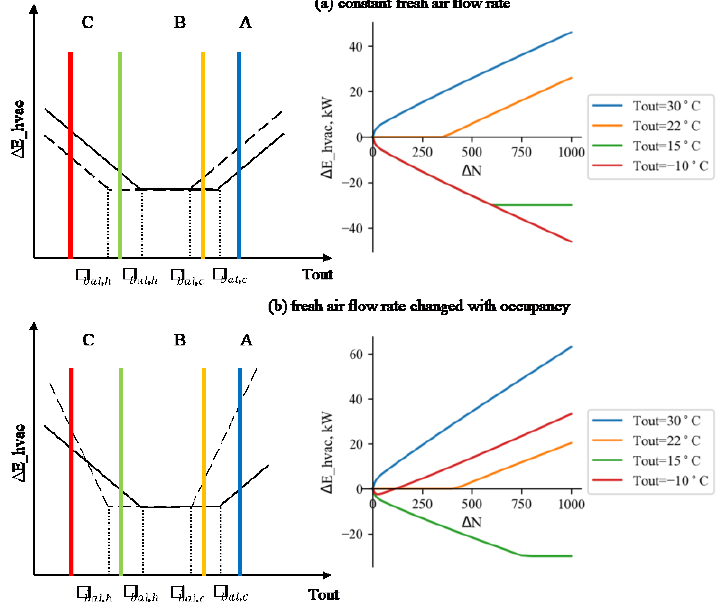
Figure 9. Influence of ∆ N on ∆ E hvac at different T out with different fresh air control strategies: ( a ) constant fresh air volume and ( b ) fresh air volume changed with occupancy.